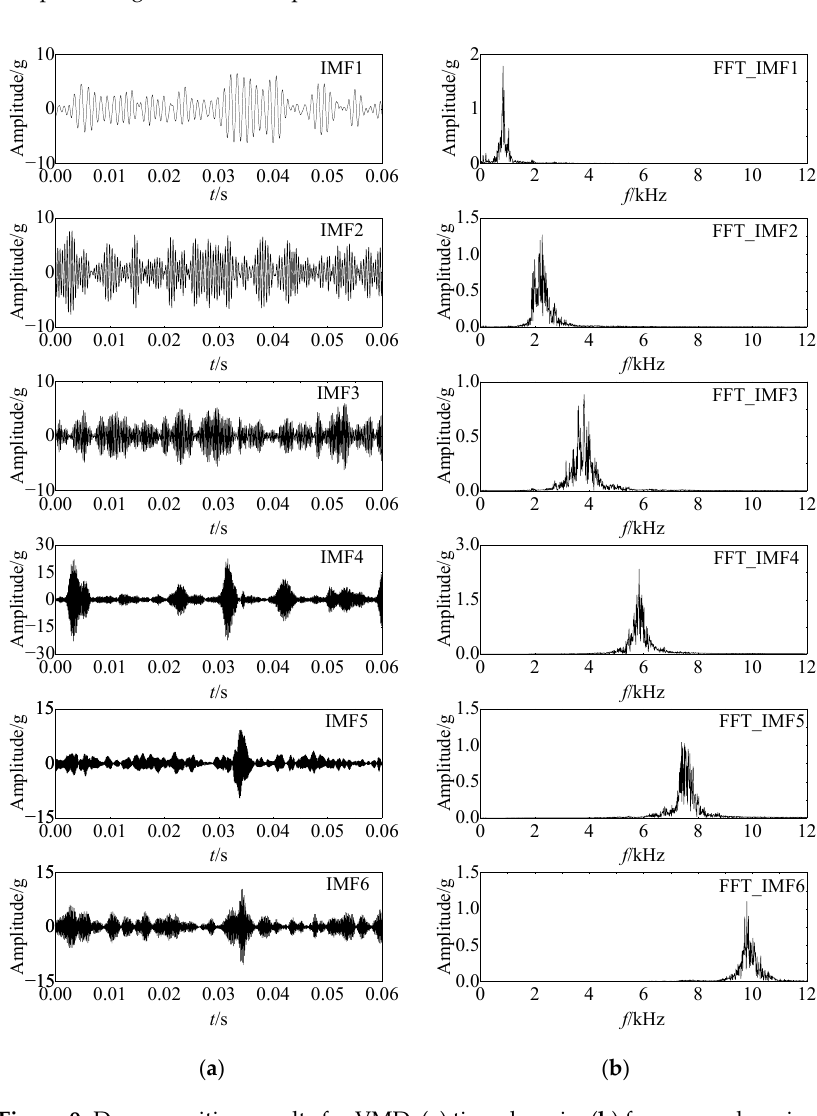
Figure 9. Decomposition results for VMD: ( a ) time domain; ( b ) frequency domain.